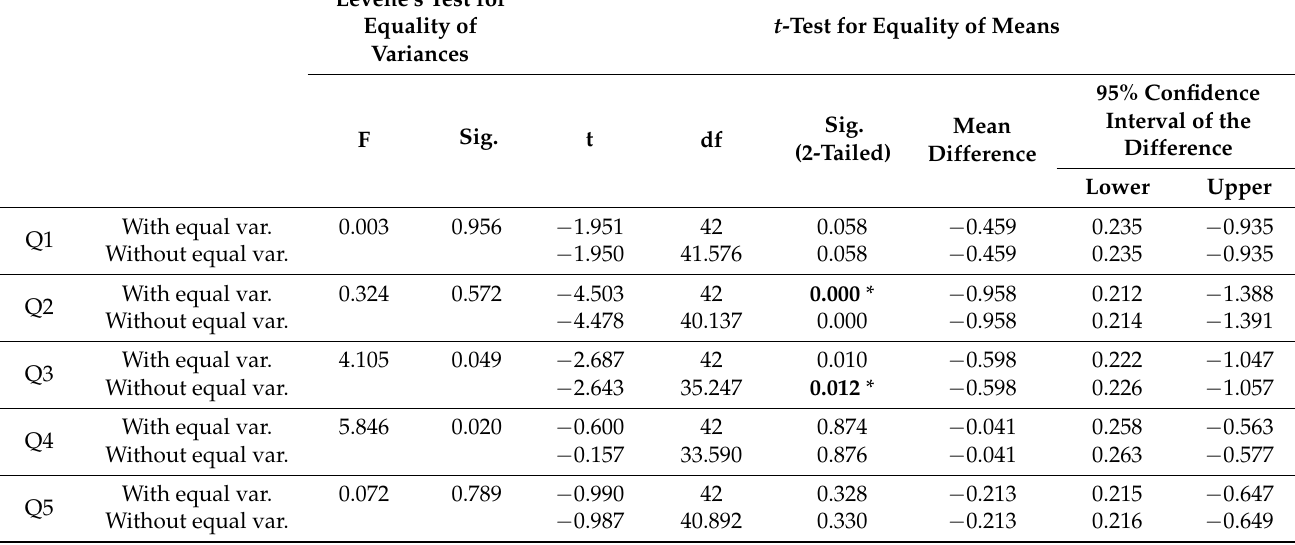
Table 6. Students’ attitudes toward satisfaction